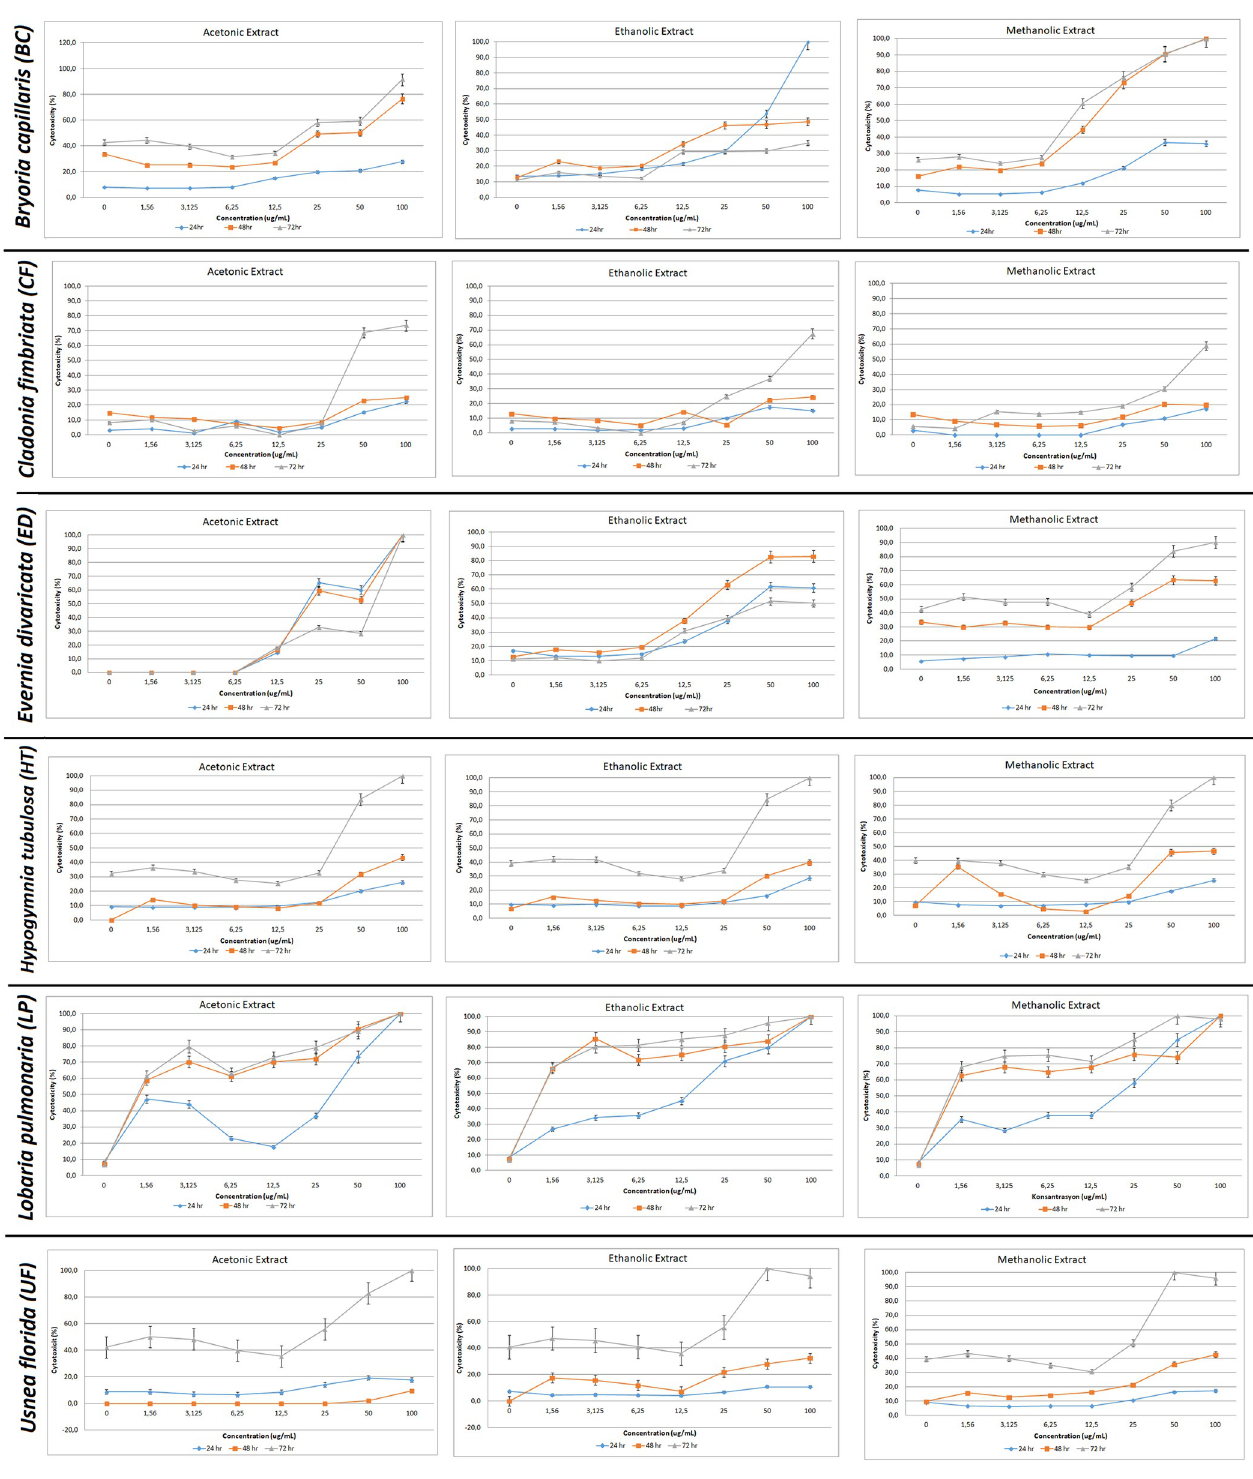
Fig 3. Cytotoxicity results by lactate dehydrogenase (LDH) assay. PC-3 cells were treated with acetone, ethanol and methanol extracts of Bryoria capillaris , Cladonia fimbriata , Evernia divaricata , Hypogymnia tubulosa , Lobaria pulmonaria , and Usnea florida cells at 24, 48, 72 hours.